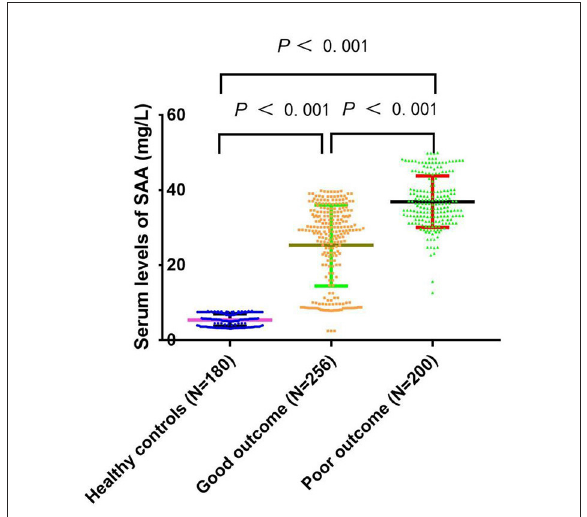
FIGURE2 Comparison of SAA concentrations among the poor prognosis, good prognosis, and healthy controls. SAA denotes serum amyloid A. SAA concentrations are reported as the medians and interquartile